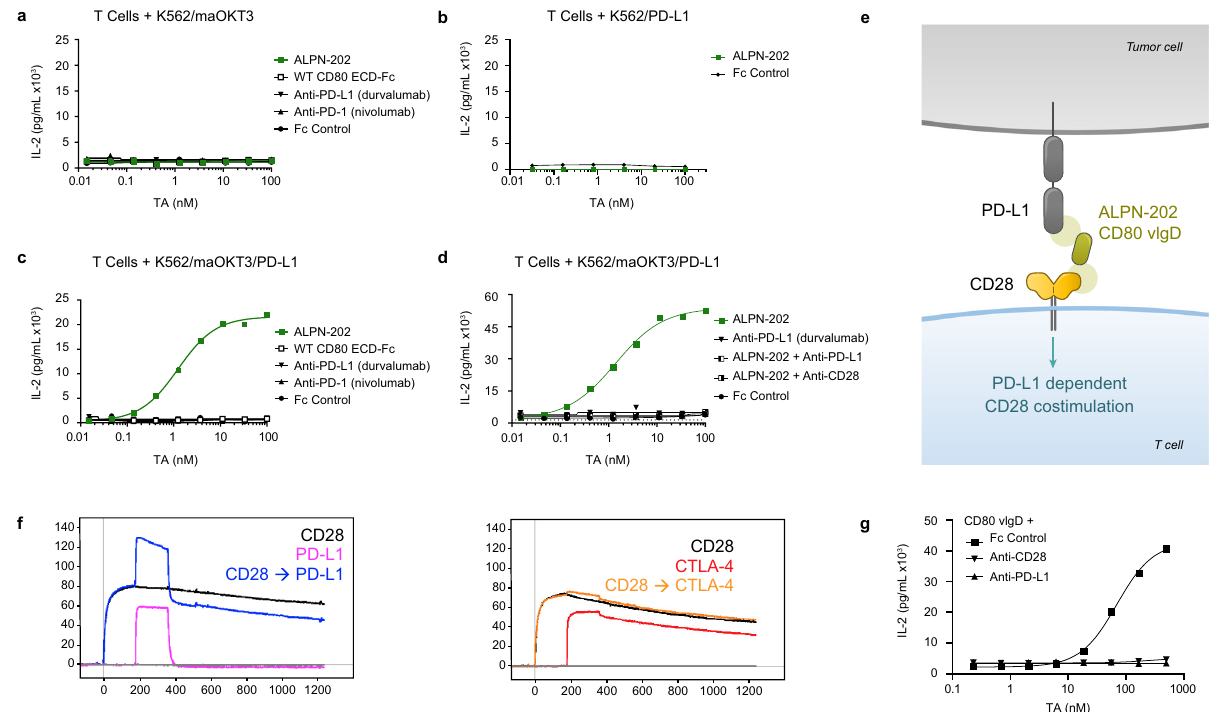
Fig. 2 CD28 costimulation by ALPN-202 requires TCR activation and co-binding to PD-L1. Primary human T cells, were co-cultured for 24 h with test articles (TA) and K562 cell arti fi cial antigen-presenting cells (aAPC) expressing membrane anchored anti-CD3 clone OKT3 (maOKT3), PD-L1, or both. a In the absence of PD-L1 to anchor ALPN-202 on the aAPC, no increase in IL-2 was detected above background. b In the absence of TCR stimulation (via maOKT3), no increase in IL-2 was observed. c When both maOKT3 and PD-L1 were present on the aAPC, ALPN-202 (green line) induced a strong dose- dependent costimulatory signal above that of WT CD80 ECD-Fc or PD-(L)1 blockade alone. WT wild type; ECD extracellular domain. d The costimulatory activity of ALPN-202 was inhibited when combined with blocking antibodies to either PD-L1 or CD28, con fi rming the requirement for dual binding to induce costimulation. e Schematic illustrating how a monomeric (no Fc) CD80 variant Ig domain (vIgD) binds PD-L1 and engages CD28 in trans. f Overlaid SPR sensorgrams for two paired serial injections of monomeric CD28 (black line) followed by PD-L1 (blue line) or CTLA-4 (orange line) against ALPN-202 surfaces. Data were collected using two serial 180 s, 1500 nM injections. Single analyte injections of PD-L1 (pink line) or CTLA-4 (red line) were made by vIgD with saturating anti-PD-L1 antibody, anti-CD28 antibody, or Fc control for 24 h. For ( a – d ), and ( f ), each data point is mean concentration of IL-2 for each sample run in duplicate wells. Data shown are representative of three separate donors run independently. Source data are provided as a Source Data fi